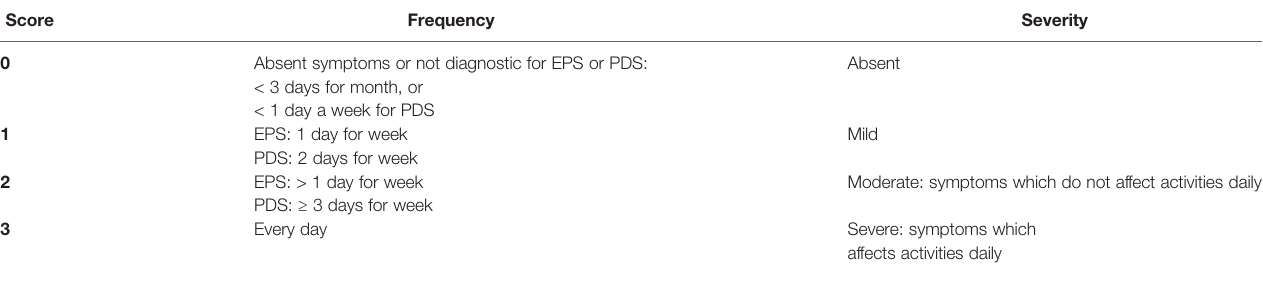
TABLE 1 | Questionnaire and score system for the clinical evaluation of